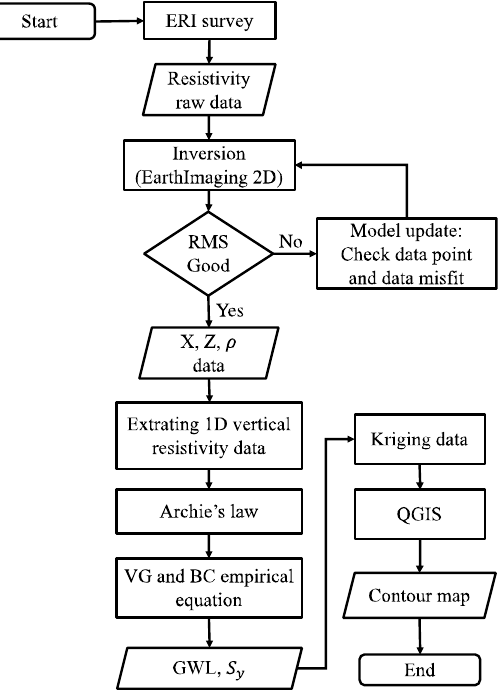
Figure 5. Workflow of the study.